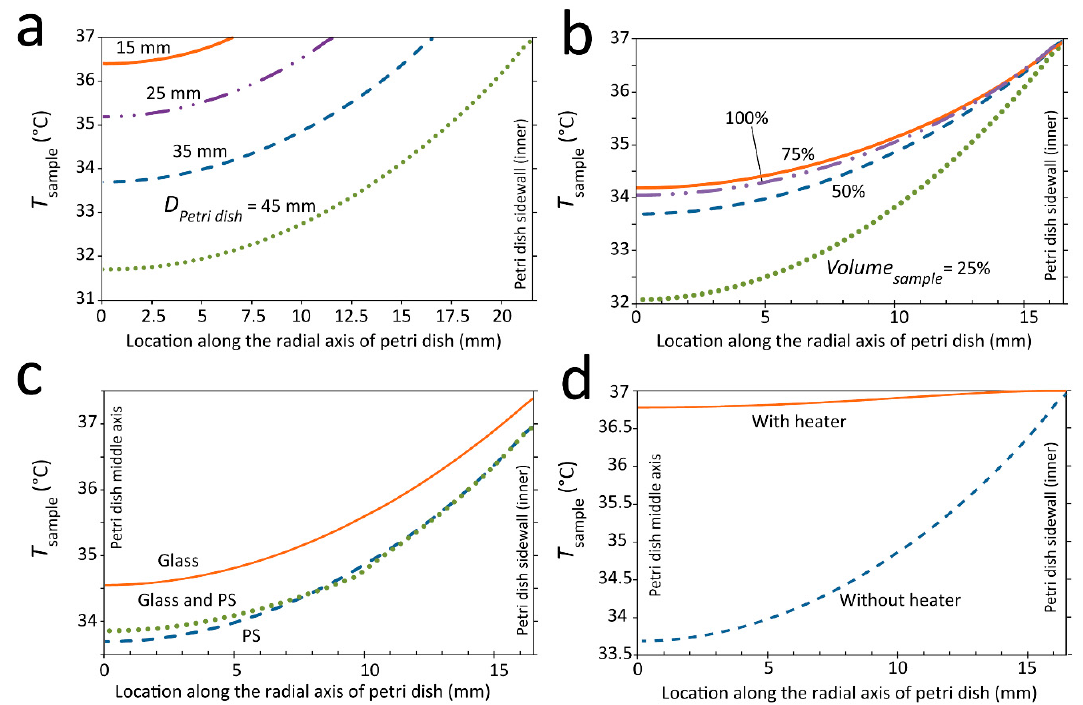
Figure 4. Numerical characterization of the temperature profile along the bottom surface of the Petri dish with respect to Petri dish parameters, including ( a ) Petri dish diameter ( D Petri dish ), varying from 15 to 45 mm. ( b ) Volume of biological sample stored inside the Petri dish ( V sample ), varying from 25% to 100%. ( c ) Material of the Petri dish, for the cases of polystyrene, polystyrene-glass (with glass only implemented close to the central region of the Petri dish bottom surface) and glass. ( d ) Incorporation of a heater underneath the Petri dish releasing 187 mW. The detailed temperature contours across the middle cross-section of the Petri dish obtained at the above conditions are presented in Figures S6–S9.